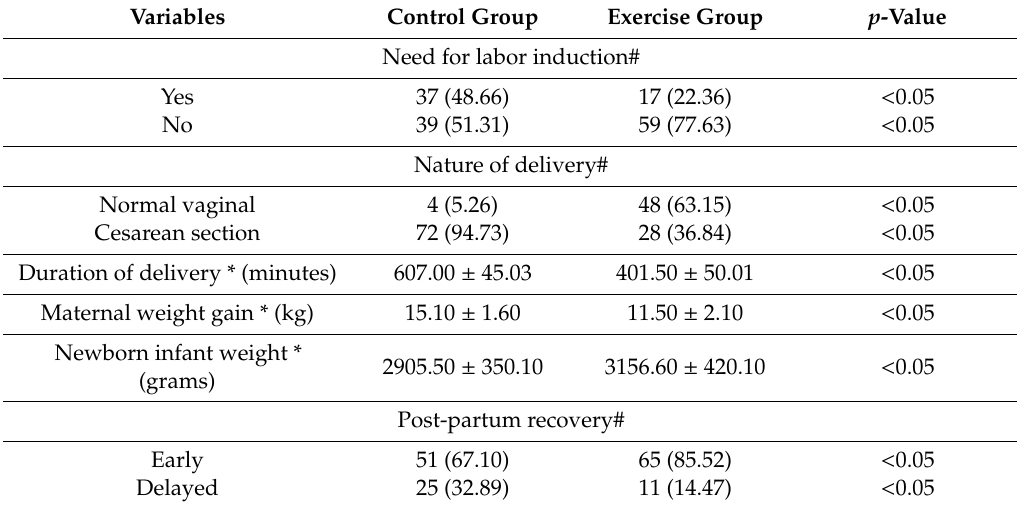
Table 4. Obstetrical information of the subjects in control ( n = 76) and experimental ( n = 76)